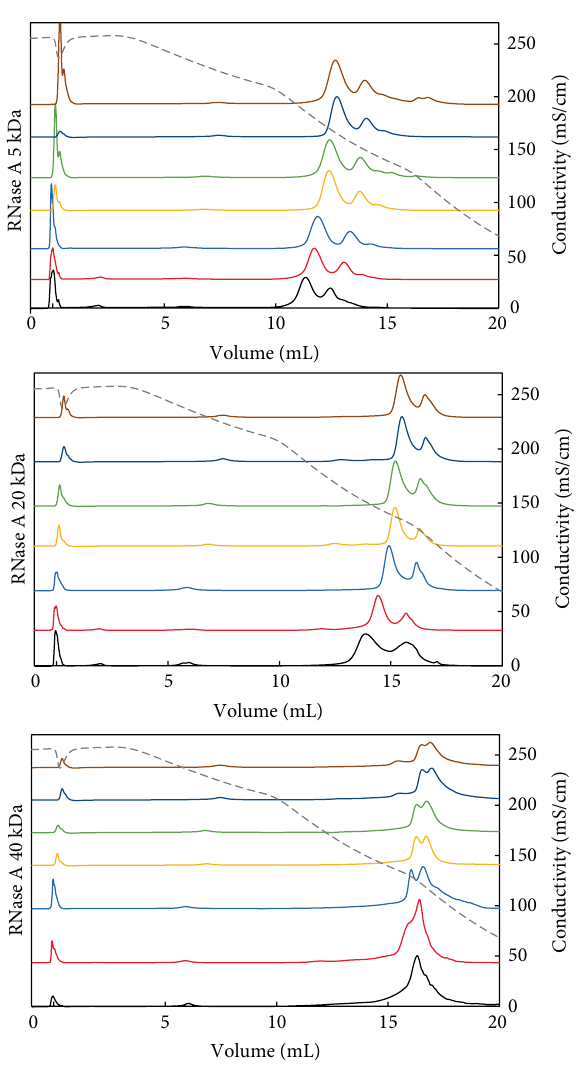
Figure 4: Comparison of PEGylated Ribonuclease A separation using different PEGylated monoliths series configurations. Ribonuclease A PEGylation reactions with PEG molecular weights of 5.0, 20.0, and 40.0 kDa were separated using PEGylated monoliths modified with PEGs of 1.0, 10.0, and 20.0 kDa in seven different configurations: 1.0 kDa (black line), 10.0 kDa (red line), 20.0 kDa (light blue line), 10.0-20.0 kDa (yellow line), 20.0-10.0 kDa (green line), 1.0-10.0- 20.0 kDa (dark blue line), and 20.0-10.0-1.0 kDa (brown line). Each experiment was carried out by triplicate. Conductivity was also measured and is presented in the chromatograms (gray dashed